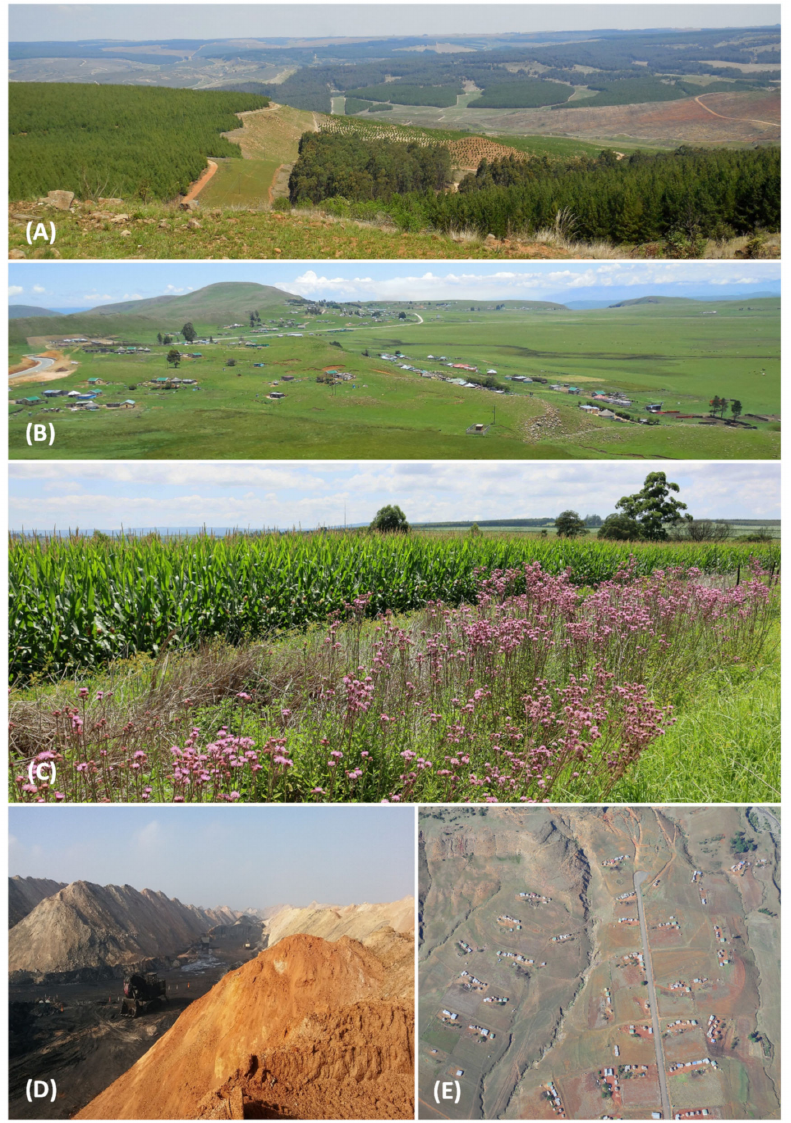
Figure 1. Photographic examples of key threats to the Grassland Biome in South Africa: ( A ) com- mercial plantation forestry, Badplaas, Mpumalanga (14 October 2017); ( B ) insidious rural sprawl in the KwaZulu-Natal Midlands, KwaZulu-Natal (11 January 2018); ( C ) cropping with corn, Zea mays L. (Poaceae) (background) and encroachment of invasive non-native plants such as Pompom Weed, Campuloclinium macrocephalum (Less.) DC. (Asteraceae) (foreground), KwaZulu-Natal Midlands, KwaZulu-Natal (21 January 2021); ( D ) mines such as Khwezela Colliery, Witbank, Mpumalanga (29 April 2017); ( E ) settlement expansion and formalisation, Mnweni, KwaZulu-Natal (14 November 2017). All photos by C. Carbutt except Figure 1D, credited to G.N. Le Roux and used with